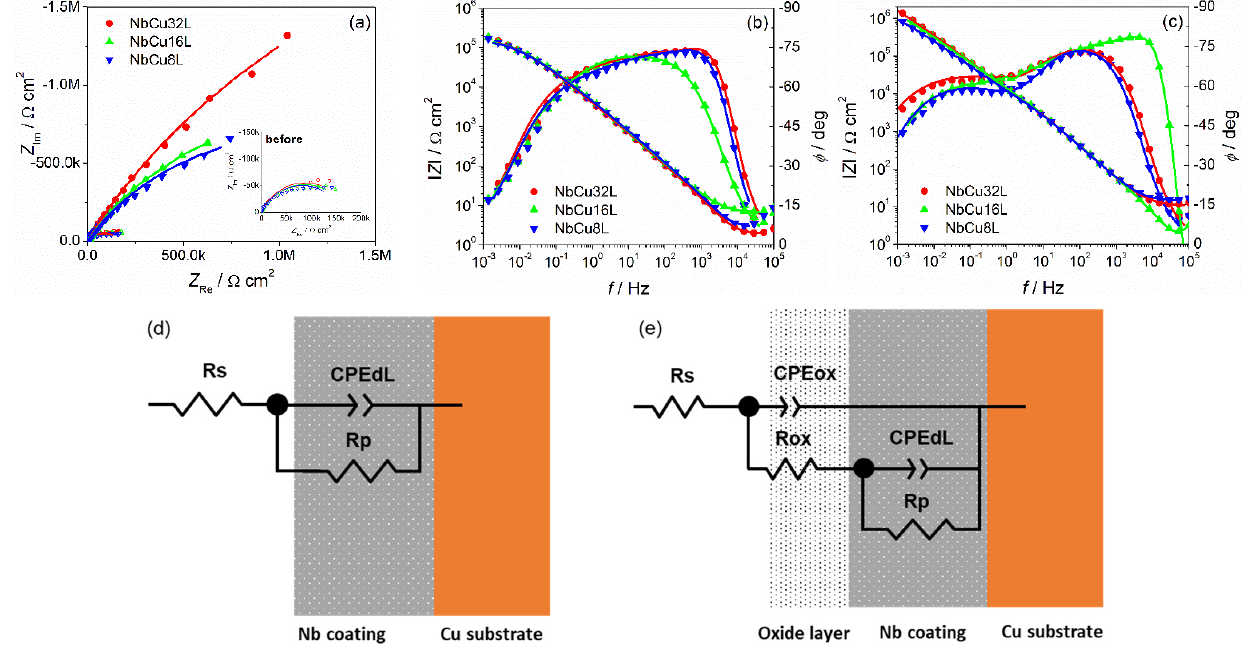
Figure 5. Electrochemical impedance spectra of Nb coatings on Cu in O 2 -saturated 0.05 M H 2 SO 4 + 0.1 ppm F − (pH = 1.4) solution at open circuit potential, at 90°C: ( a ) Nyquist and ( b ) Bode plots before and ( c ) after polarization at constant potential E = 2 V for 6 h; ( d ) single time constant EEC and ( e ) two time constants EEC. Symbols are experimental data and continuous lines are simulated by fitting to the EEC.